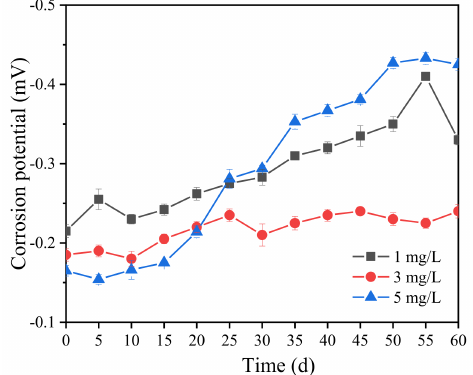
Figure 2. Correlation between initial chlorine concentration and corrosion